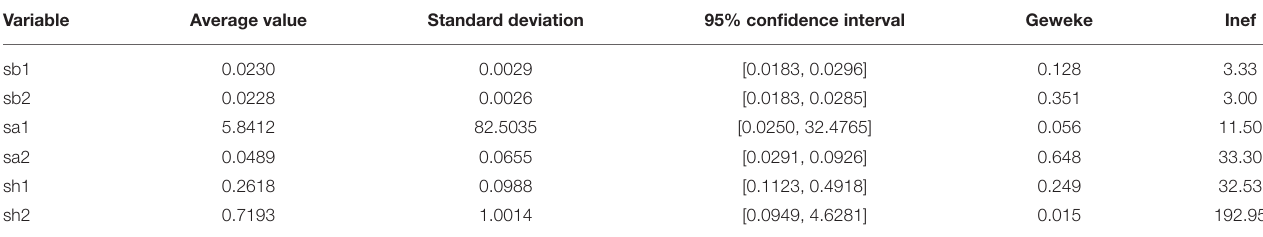
TABLE 2 | Parameter estimates of the quantitative model.